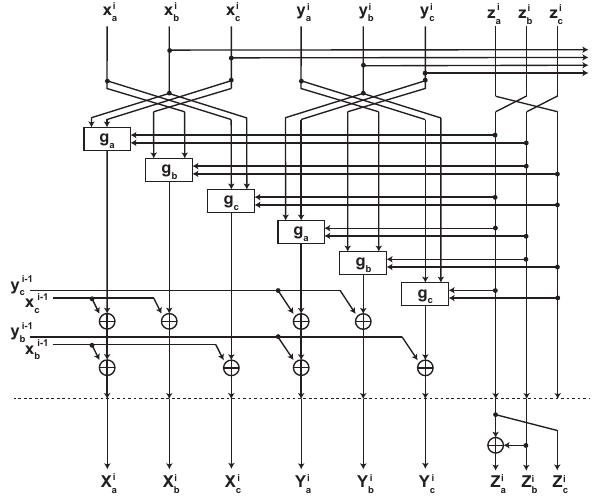
Figure 7: Changing of the guards sharing of h R (Definition